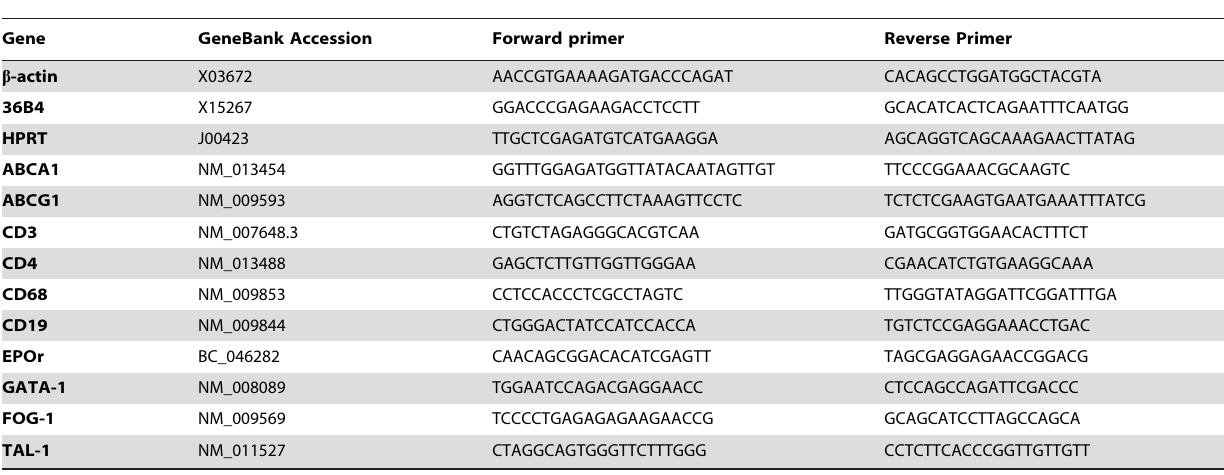
Table 1. Primers used for quantitative real-time RT-PCR